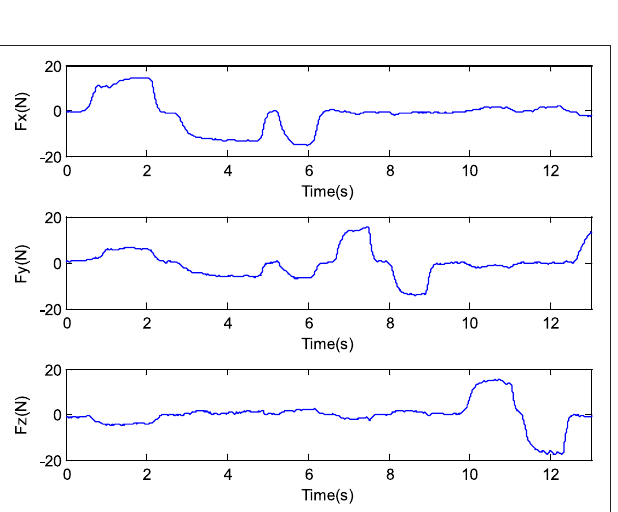
FIGURE 7 | The force signals measured by the 3D force sensor.